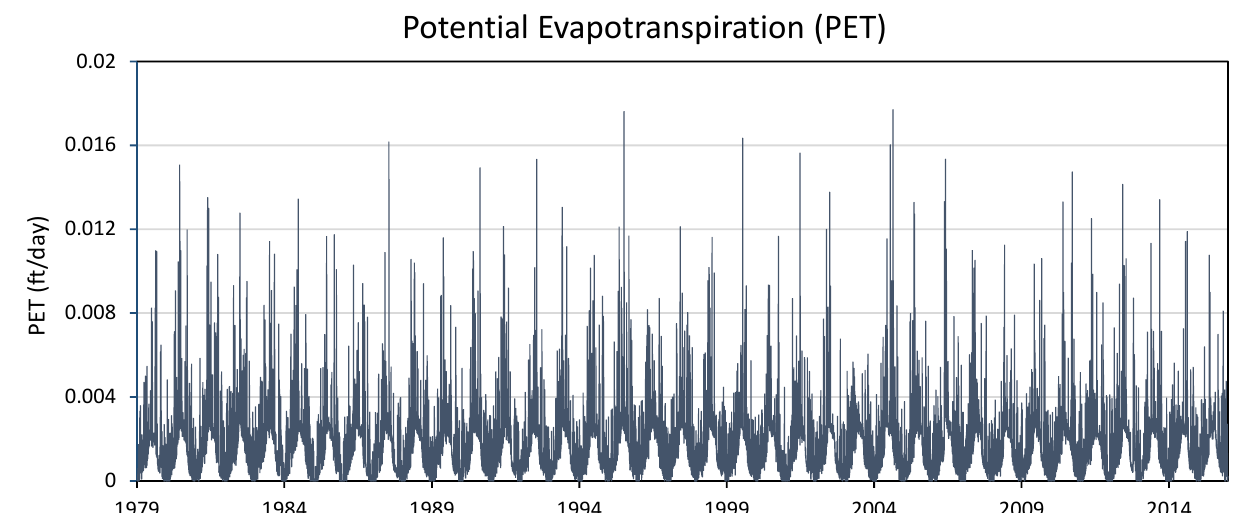
Figure A10. Input data—potential evapotranspiration (PET) calculated with the Hargreaves method [74] using minimum, maximum, and average temperature at the lower YRB.